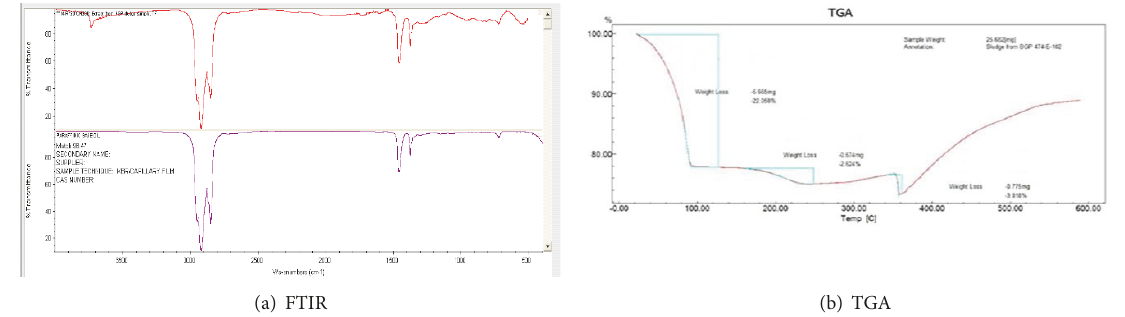
Figure 3: (a) The FTIR spectra confirmed that the hydrocarbon (dichloromethane soluble part) mainly contained hydrocarbon. (b) The TGA spectra showed that the sample lost around: (a) 22% of its original weight at 100 ∘ C, which represents moisture and volatile hydrocarbons; and (b) 2.6% of its weight from 100 ∘ C to 250 ∘ C representing heavy